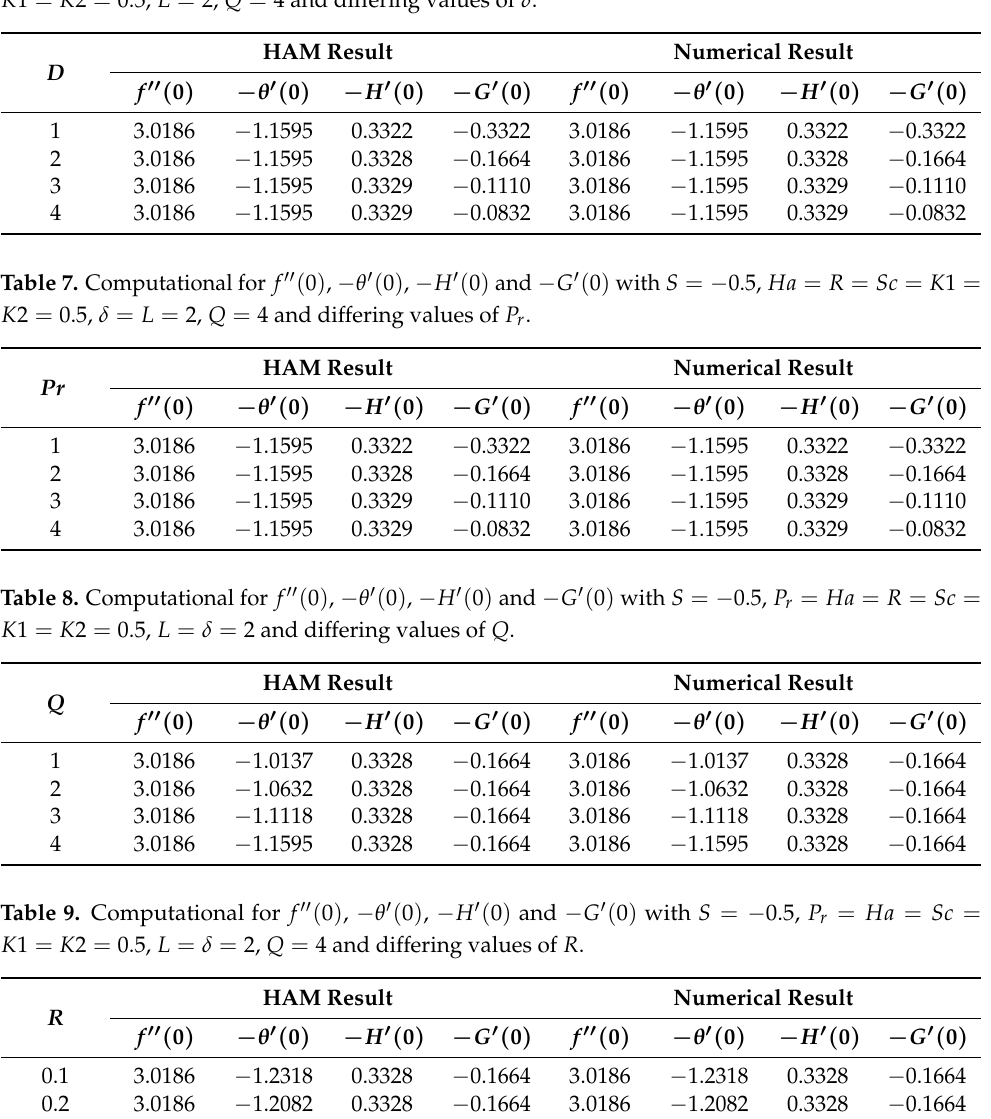
Table 6. Computational for f (cid:48)(cid:48) ( 0 ) , − θ (cid:48) ( 0 ) , − H (cid:48) ( 0 ) and − G (cid:48) ( 0 ) with S = − 0.5, P r = Ha = R = Sc = K 1 = K 2 = 0.5, L = 2, Q = 4 and differing values of δ .